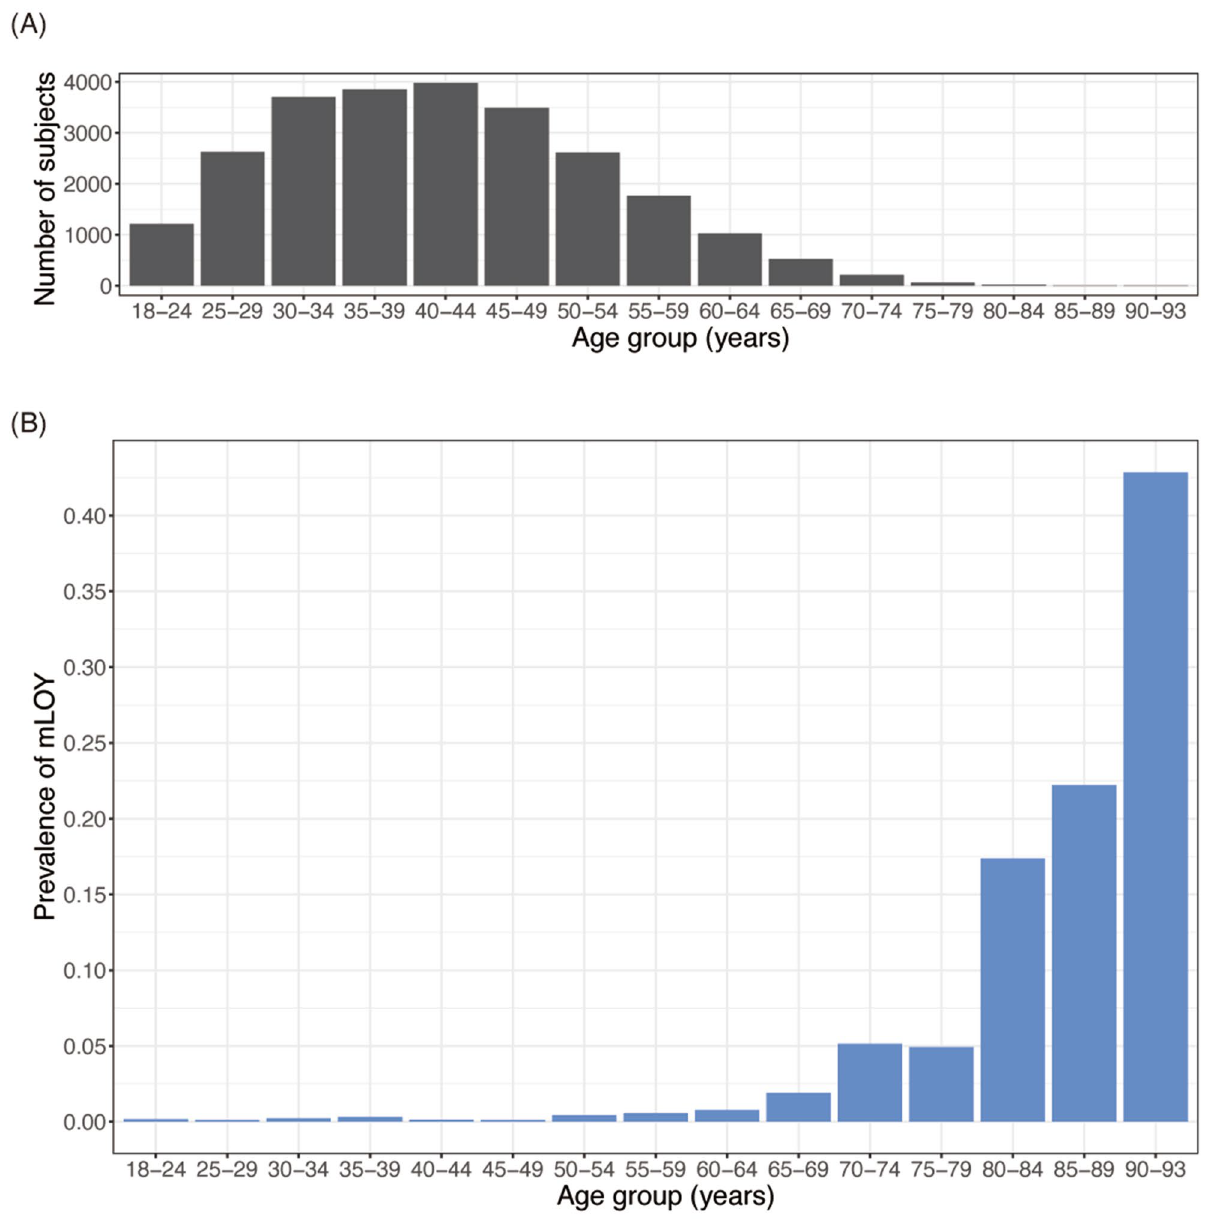
mLOY. mLOY indicates mosaic loss of the Y